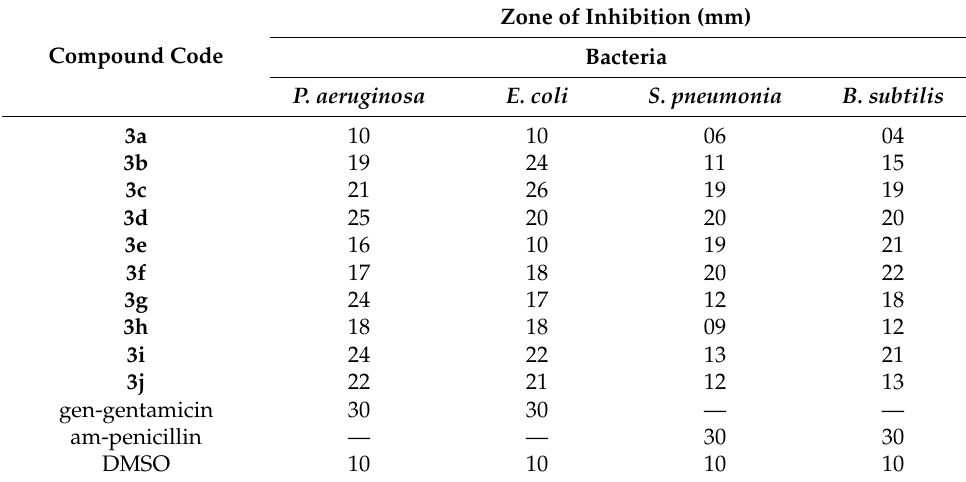
Table 5. Antibacterial activity of benzimidazole derivatives.